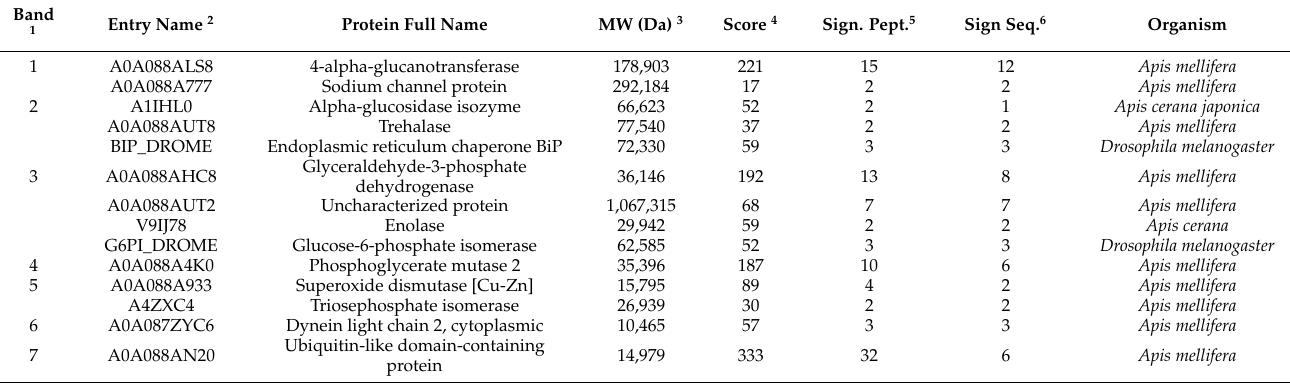
Figure 2. Representative gels (4–12%, Coomassie staining) of fractions obtained after size exclusion chromatography of cytosolic extracts of larvae, pupae and adults of European hornet. Left: lanes 1–3, fraction 10 from larvae (L), pupae (P) and adults (A), respectively; lanes 4–5, fraction 15 from larvae and pupae, respectively; lane 6, molecular mass marker (M) (kD). Right: lane 1, fraction 15 from adults; lane 2, molecular mass marker; lanes 3–5, fraction 19 from larvae, pupae and adults, respectively. Continuous line rectangles indicate bands excised and analyzed by mass spectrometry that gave protein identifications (Table 4). Dotted line rectangles indicate bands excised and analyzed by mass spectrometry that did not result in protein identification. Table 4. Protein identification in fractions from cytosolic extracts of larvae, pupae and adults of European hornet ( V. crabro ) using mass